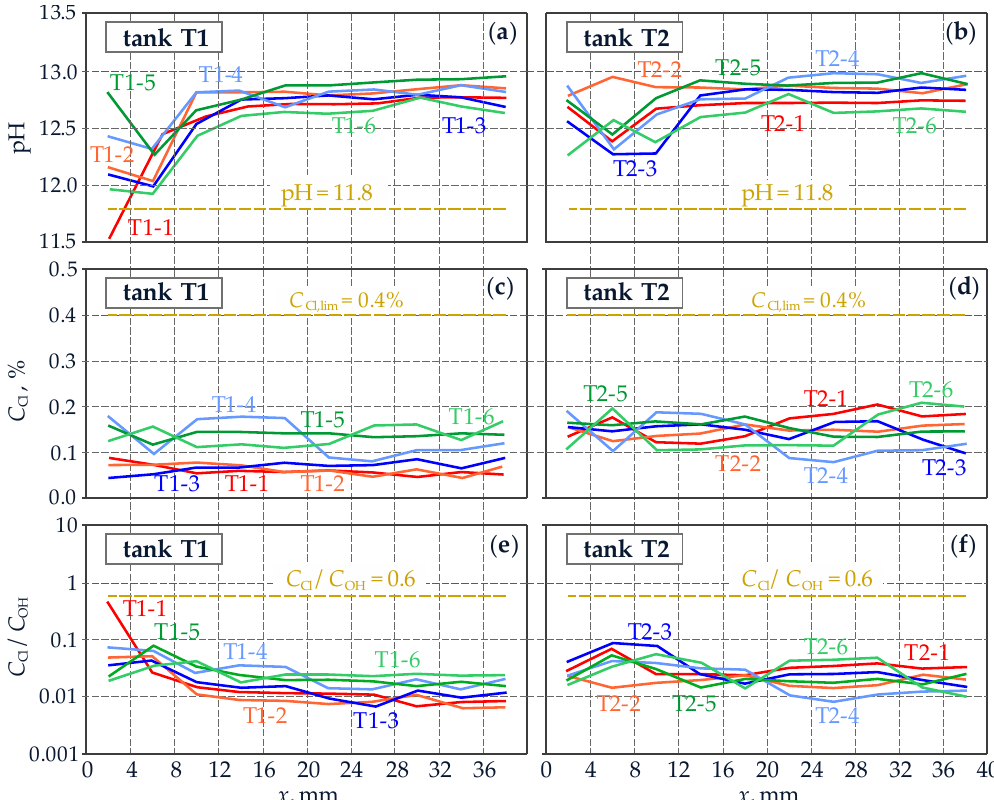
Figure 7. Test results for cores drilled from the tanks—protective properties of pore solution against reinforcing steel: ( a , b ) distribution of pH values in the direction x of concrete cover thickness for rebars in the tanks T1 and T2; ( c , d ) profiles of chloride concentrations in the direction x of concrete cover thickness for rebars in the tanks T1 and T2; and ( e , f ) distributions in the direction x of concrete cover thickness, values of concentration ratios of chloride and hydroxide ions — the Hausman criterion.